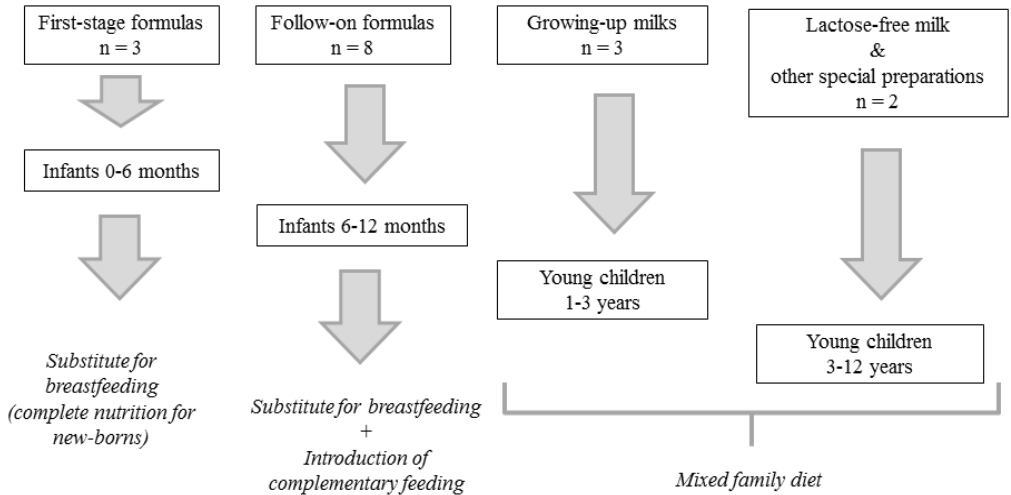
Figure 1. Classification of the different milk-based preparations for infants and children analyzed in this study (formulas and